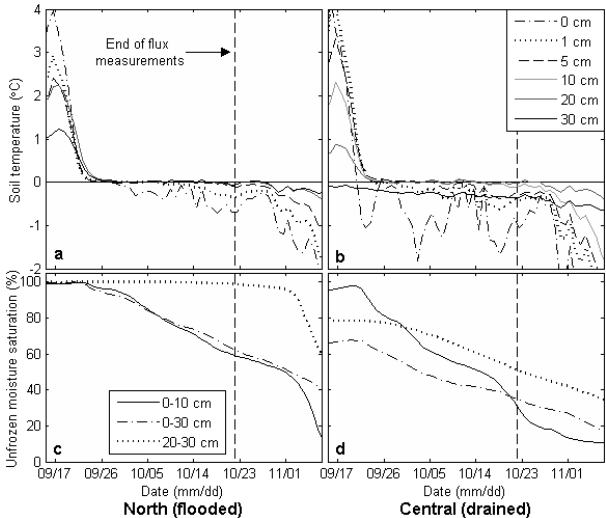
Figure 5. Half-hourly CH 4 flux measurements and selected daily average environmental 2 Fig. 5. Half-hourly eddy covariance CH 4 flux measurements and measurements. 3 selected daily average environmental measurements. high winds corresponded to relative drops in pressure. Winds were predominantly from the east but ranged from all sectors (Fig. 1